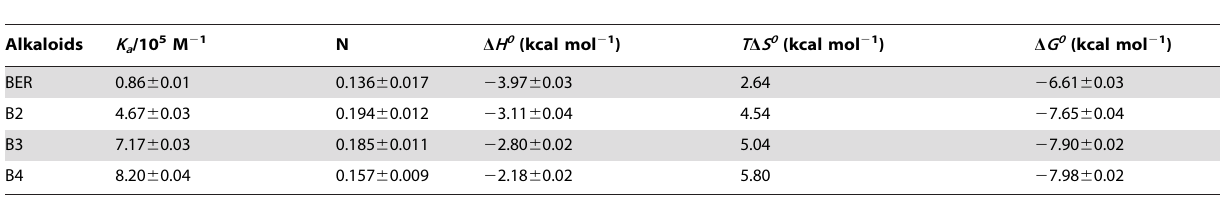
Table 2. Thermodynamic parameters for the association of alkaloids with tRNA from ITC a .